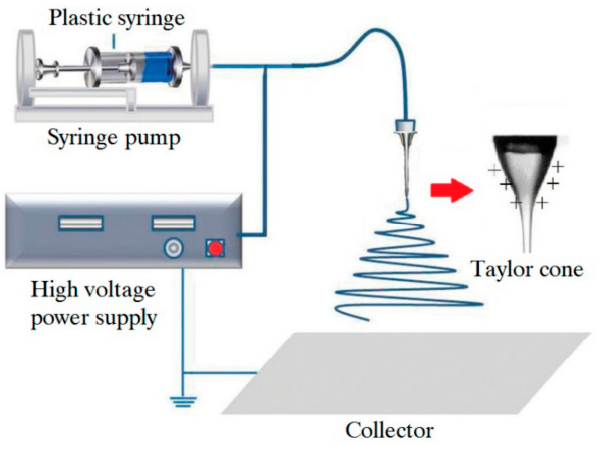
Figure 2. Schematic diagram for the demonstration of polymer nanofibers produced by electrospinning. Reprinted from [36].